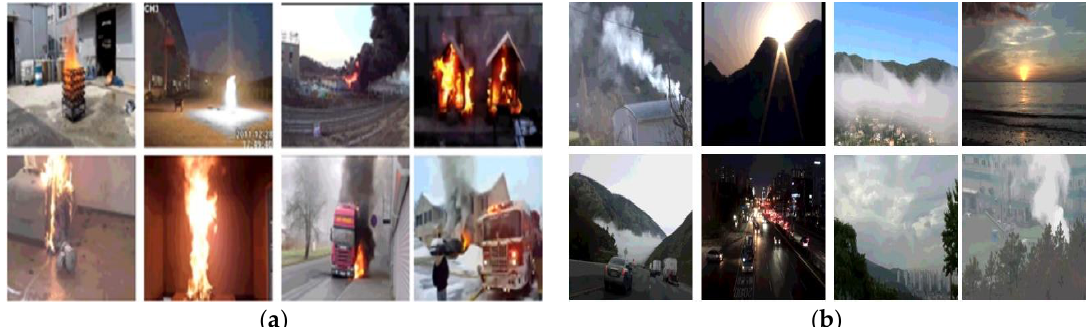
Figure 12. Sample still shots taken from video clips for the experiment of majority voting and interpretation of dynamic fire behavior: ( a ) real fires, and ( b ) non-fires such as chimney smoke, sunset, cloud, fog, and light.